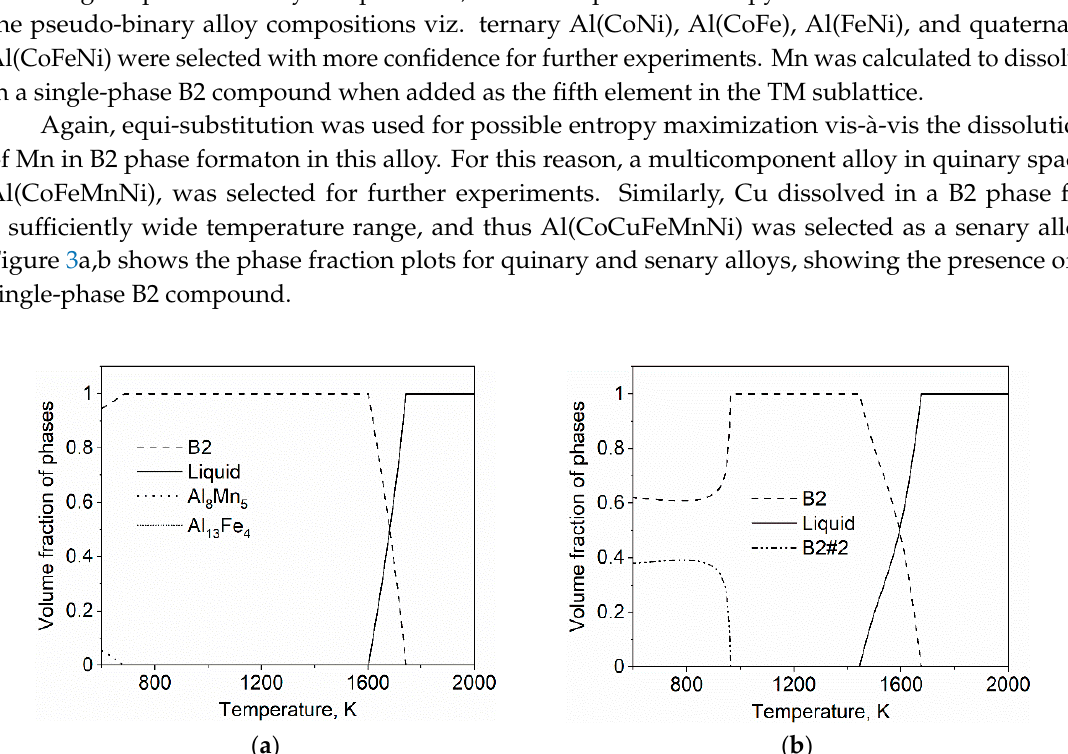
Figure 3. Calculated phase fraction plot for ( a ) quinary Al(CoFeMnNi); ( b ) senary Al(CoCuFeMnNi).